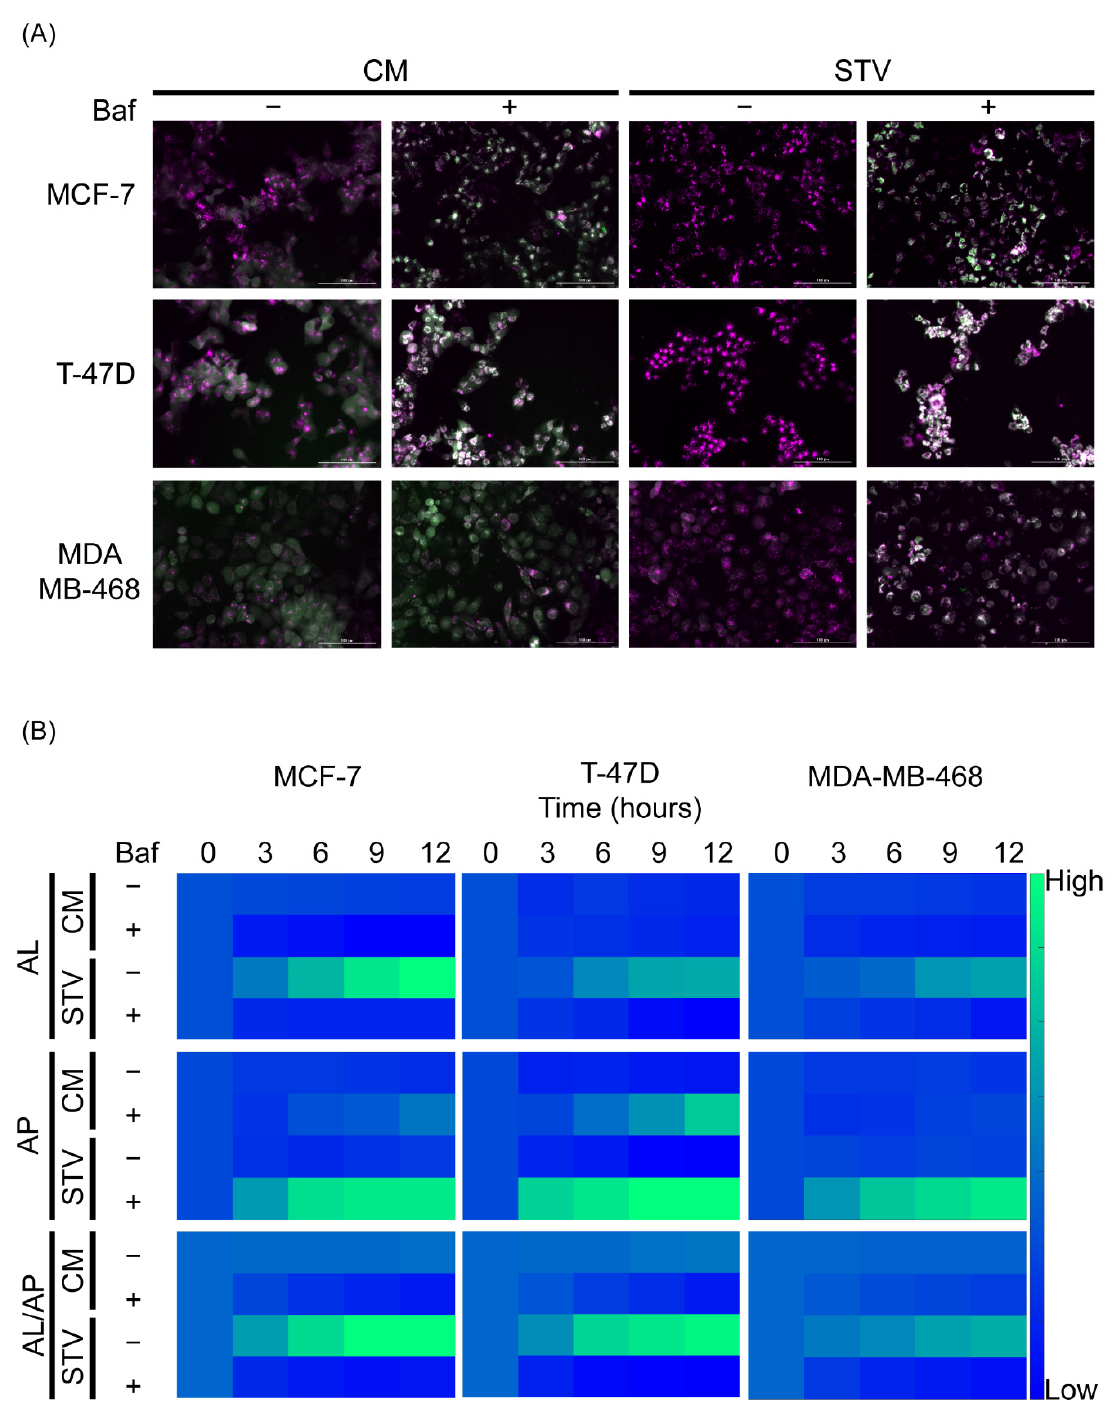
Figure 1. An mCHR-GFP tandem LC3 sensor reports dynamic changes in response to starvation-induced activation and bafilomycin-mediated degradation blockade. ( A ) Qualitative variations in the intensity and distribution of the mCherry (magenta) and GFP (green) fluorescence in three breast cancer cell lines stably expressing the autophagy sensor upon known autophagy perturbations like starvation and bafilomycin induced blockade. To emphasize the differences, only the images corresponding to 12 h post-treatment are shown. ( B ) The dynamic changes in the autophagy sensor were quantified using an image analysis pipeline designed with Cell Profiler software (Figure S1). mCherry+/GFP- puncta were measured as autophagolysosomes (AL), while mCherry+/GFP+ puncta were measured as autophagosomes (AP). Baf; bafilomycin, CM: complete medium, STV: starvation medium.